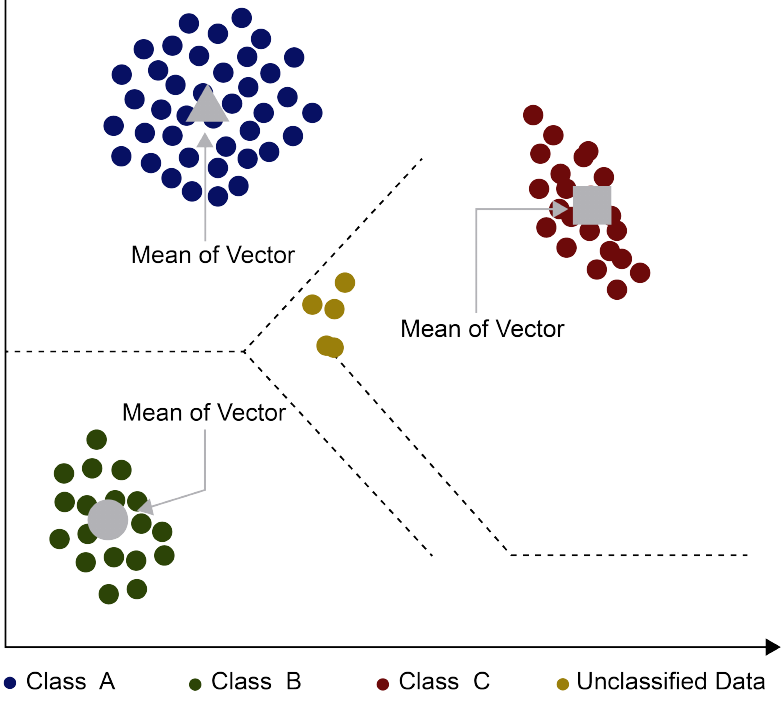
Figure 7. Principle of minimum distance